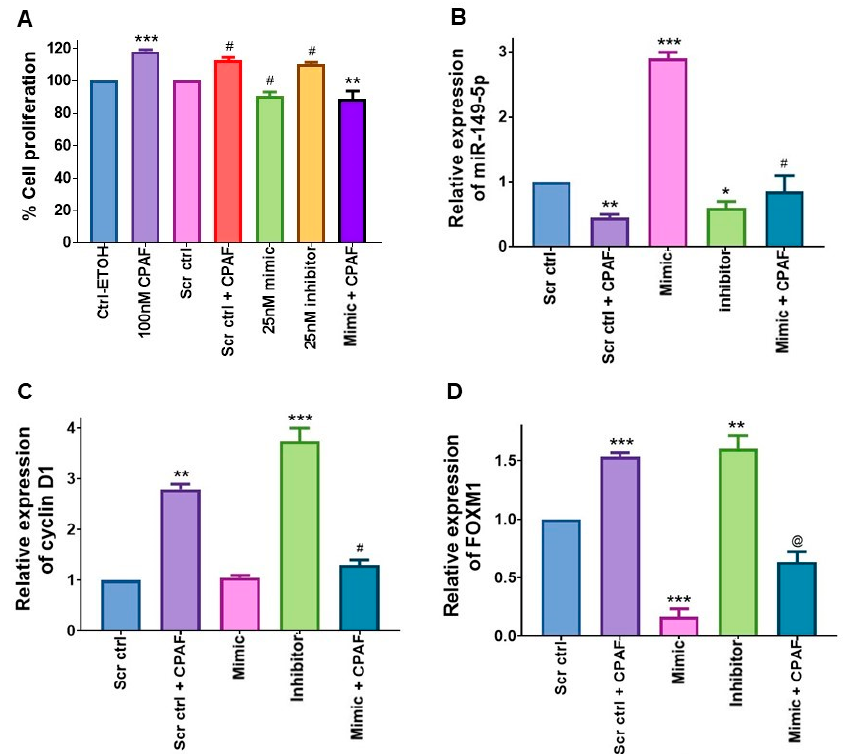
Figure 3. The effect of miR-149-5p overexpression on CPAF-mediated increased A549 cell proliferation. ( A ) A549 cells were treated with vehicle (0.1% ETOH) and 100 nM CPAF as negative and positive controls, or transfected with a 25 nM dose of Scr ctrl (± CPAF) for transfection control, or a 25 nM dose of miR-149-5p mimic (± CPAF), and an miR-149-5p-specific inhibitor. After 48 h of incubation, the cell proliferation was analyzed via the CV assay. Data are expressed as the mean ± SE of three separate experiments. Statistically significant differences were observed, according to Student’s t -test, between Ctrl-ETOH vs. CPAF (*** = p < 0.001), Scr ctrl vs. Scr ctrl + CPAF (# = p < 0.01), Scr ctrl vs. mimic (# = p < 0.05), Scr ctrl vs. inhibitor (# = p < 0.01), and CPAF vs. mimic + CPAF (** = p < 0.01). ( B ) Analysis of miR-149-5p expression was carried out via qPCR, using CPAF, miR-149-5p mimic, miR-149-5p inhibitor, and miR-149-5p mimic with CPAF. Data are expressed as the mean ± SE of three independent experiments. Statistically significant differences were observed, based on Student’s t -test, between Scr ctrl vs. Scr ctrl + CPAF (** = p < 0.01) and Scr ctrl vs. inhibitor (* = p < 0.05), and based on one-way ANOVA with the Bonferroni post hoc test between Scr ctrl vs. mimic (*** = p < 0.001) and mimic vs. mimic + CPAF (# = p < 0.001). ( C ) Analysis of Cyclin D1 was performed via qPCR with CPAF miR-149-5p mimic, miR-149-5p inhibitor, and mimic with CPAF. Data are expressed as the mean ± SE of three separate experiments. Statistically significant differences were observed, according to one-way ANOVA with the Bonferroni post hoc test, between Scr ctrl vs. Scr ctrl + CPAF (** = p < 0.01), Scr ctrl vs. inhibitor (*** = p < 0.001) and via Student’s t -test between Scr ctrl + CPAF vs. mimic + CPAF (# = p < 0.01). ( D ) FOXM1 expression analysis was carried out via qPCR, using CPAF, miR-149-5p mimic, miR-149-5p inhibitor, and mimic with CPAF. Data are expressed as the mean ± SE of three independent experiments. Statistically significant differences were observed between Scr ctrl vs. Scr ctrl + CPAF (*** = p < 0.001), Scr ctrl vs. mimic (*** = p < 0.001), Scr ctrl vs. inhibitor (** = p < 0.01), and Scr ctrl + CPAF vs. mimic + CPAF (@ = p < 0.001).